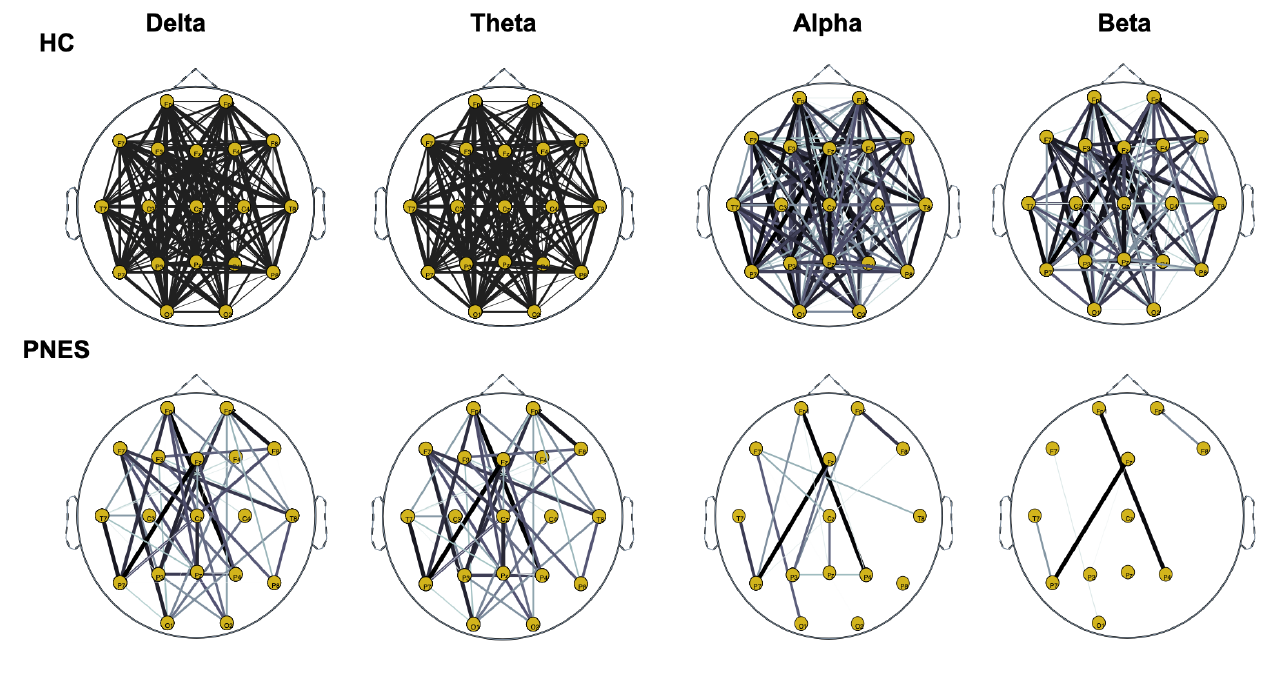
Figure 7. Distribution of PLI for th = 0.25 level of the connection strength, in healthy subjects and PNES in delta, theta, alpha, and beta frequency bands.